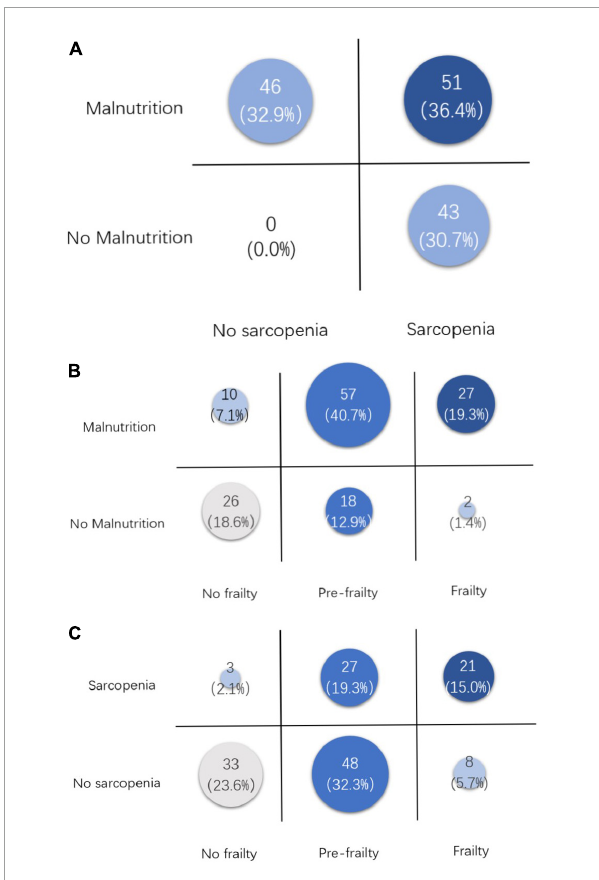
FIGURE2 Overlaps between malnutrition, frailty, and sarcopenia. (A) Overlap between malnutrition and sarcopenia. (B) Overlap between malnutrition and frailty. (C) Overlap between sarcopenia and frailty.